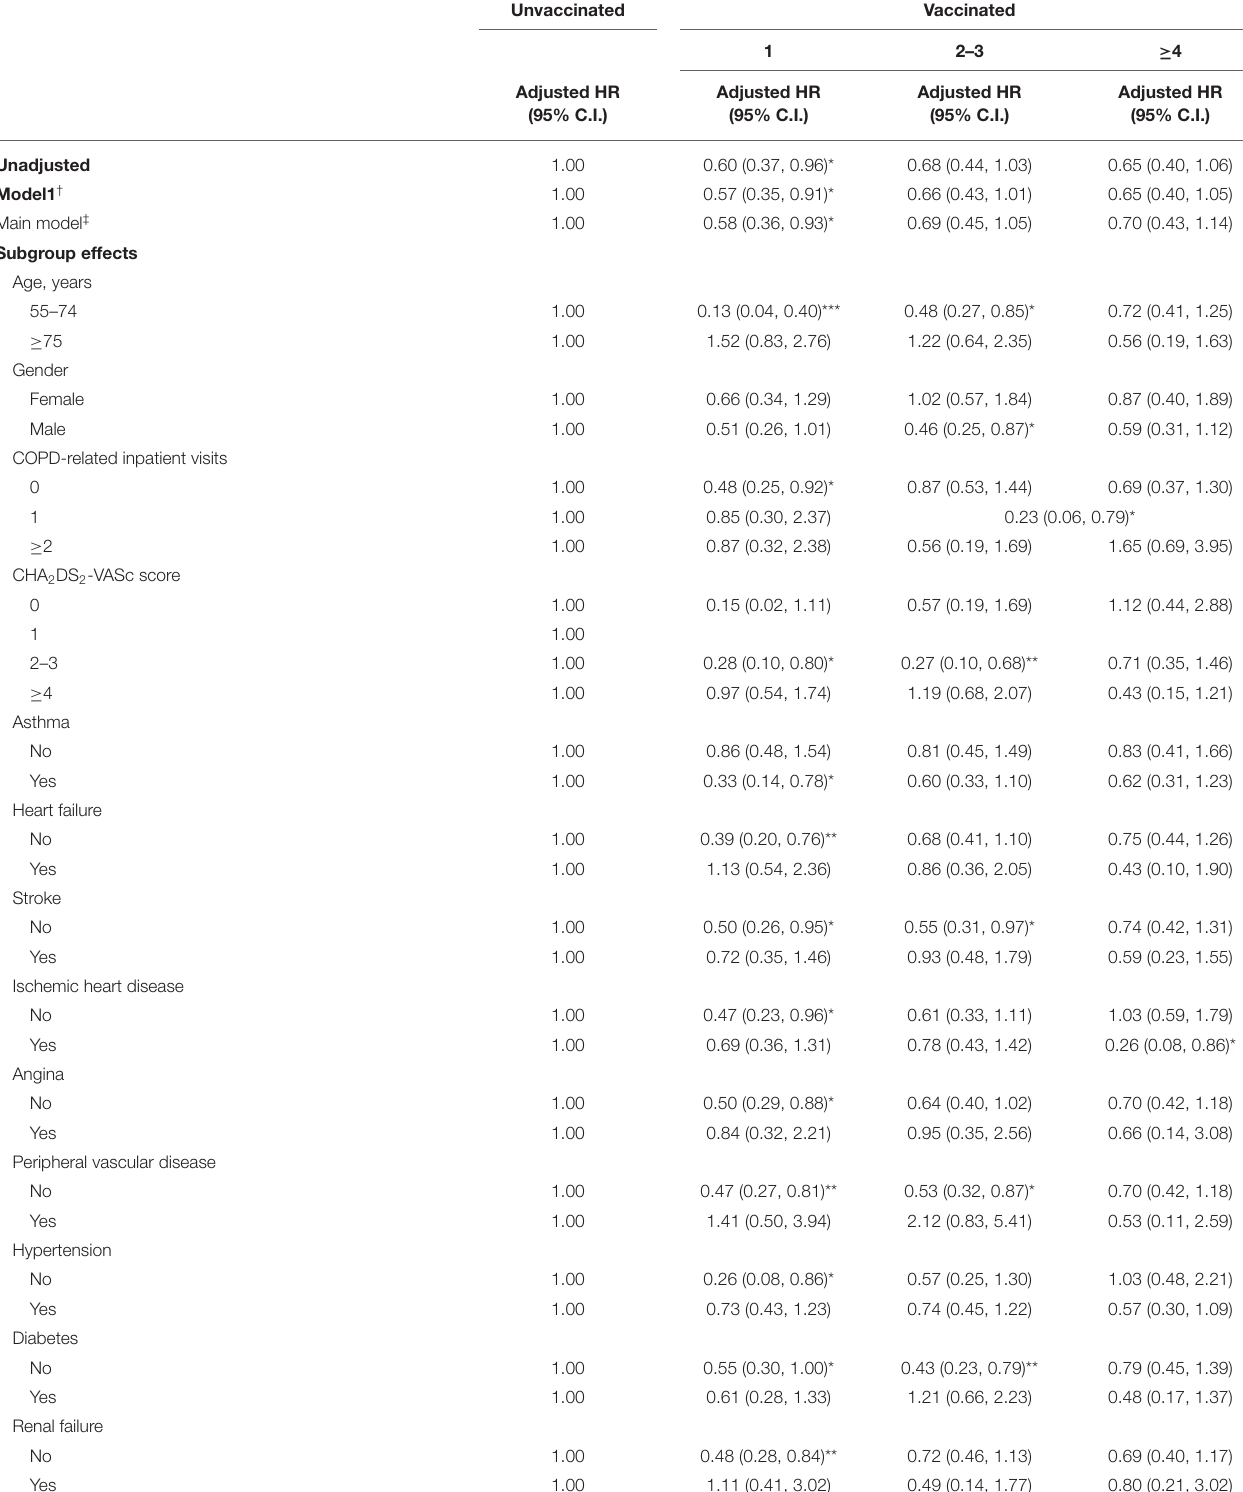
TABLE 5 | Sensitivity analysis of adjusted HRs of vaccination in risk reduction of ventricular arrhythmia in all